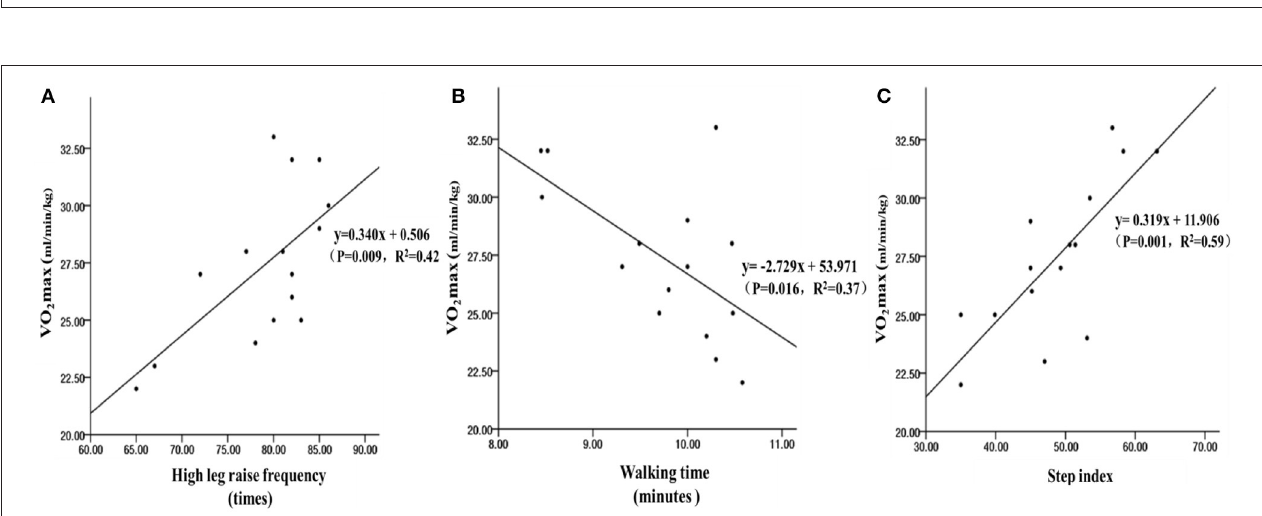
FIGURE 2 | The linear regression scatter plot of the number of 30-s high-leg raises (A) , 1,000-m walking time (B) , and 3-min step index (C) to estimate the VO 2max of natural plant-derived drug addicts.